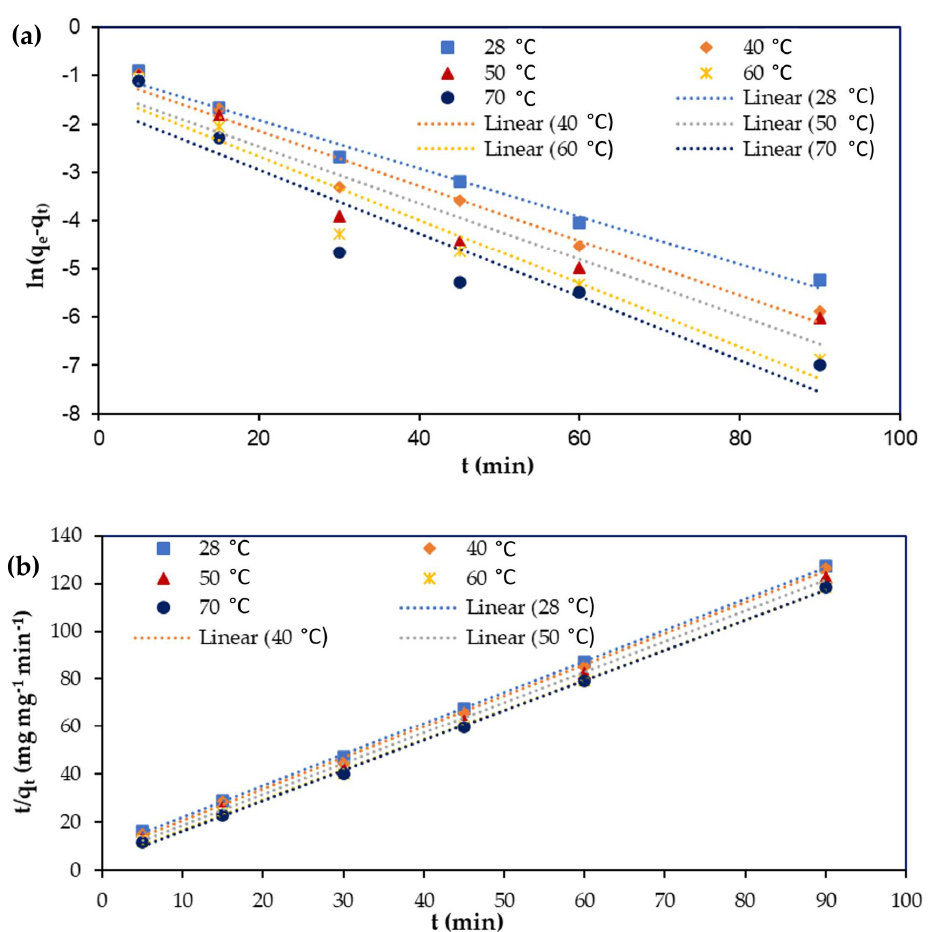
Figure 11. Adsorption kinetics modeling for the removal of Cu(II)) from aqueous solution using M-OPEFB-CNF as a bio-sorbent. ( a ) Pseudo-first-order kinetic model, and ( b ) pseudo-second-order kinetic model.